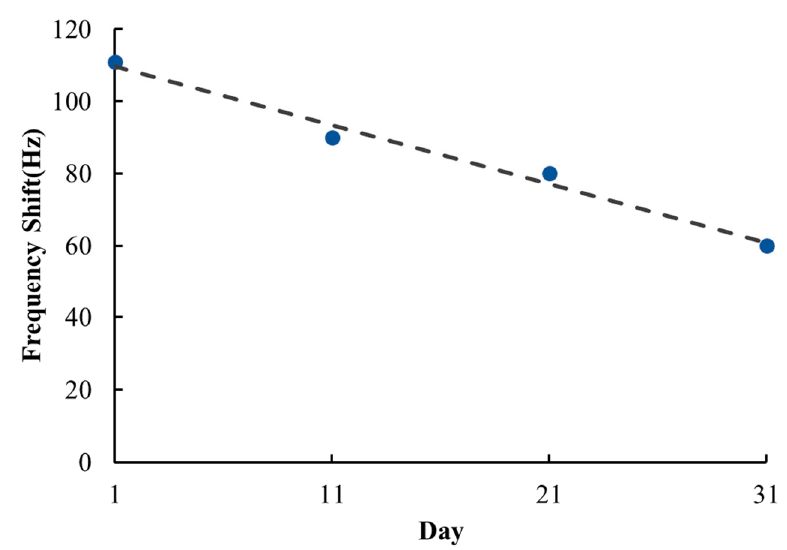
Figure 9. Responses of a SAW sensor to 1400 ppb NH 3 gas within 31 days.